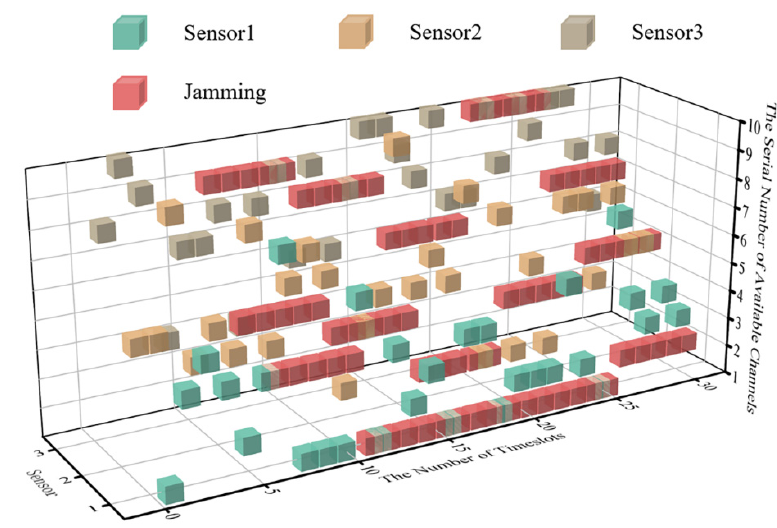
Figure 12. The cubic diagram of DAJA’s initial state with time delay.